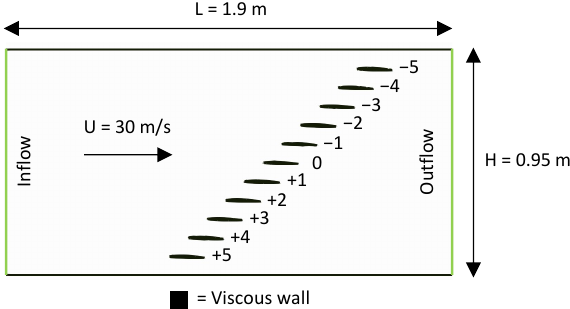
Figure 4. Schematic of cascade geometry with blade numbering convention.